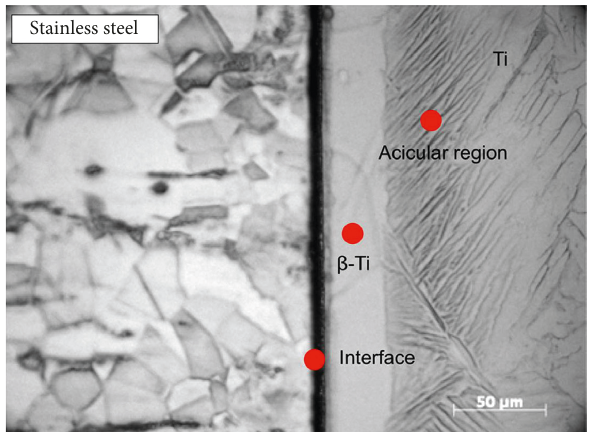
Figure 1: A typical morphology of bonded joint between Ti grade 2 and AISI 321 stainless steel. A black interface with intermetallics, bright β -Ti layer and acicular α - β Ti layer (reproduced from [34] with